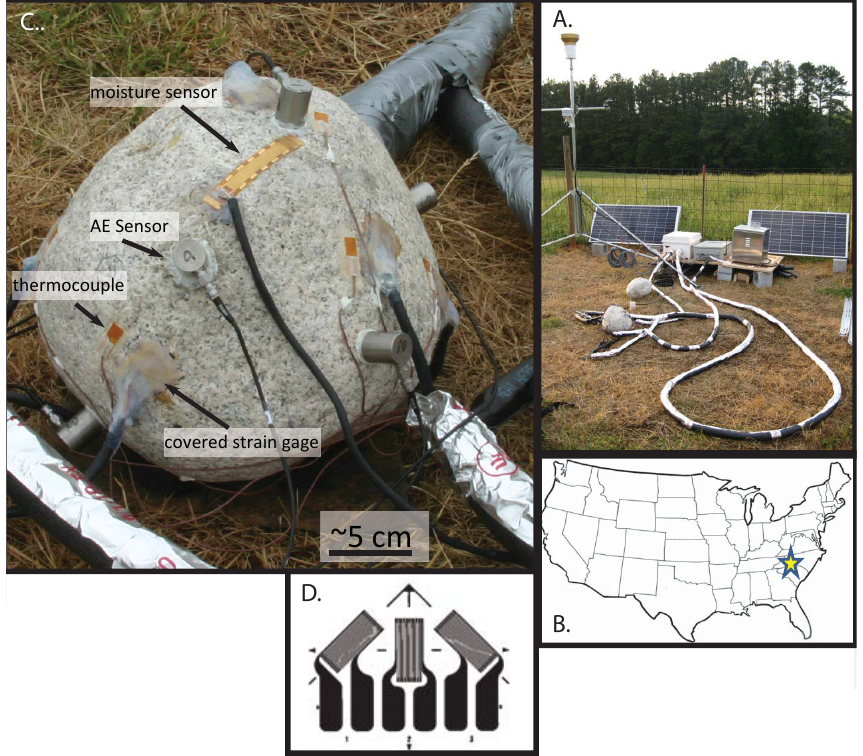
Fig. 2. (A) Photograph of the final instrumentation array and (B) map of the final deployment location for the boulder. (C) Close-up photo- graph of the instrumented boulder on site. (D) Diagram of strain rosettes used in this